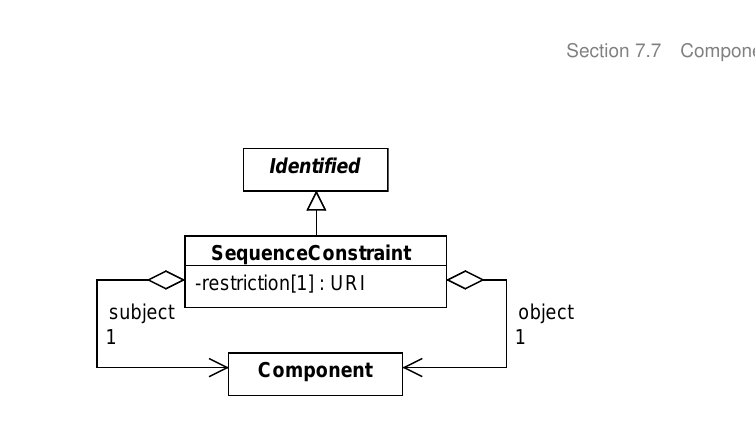
Figure 13: Diagram of the SequenceConstraint class and its associated properties.